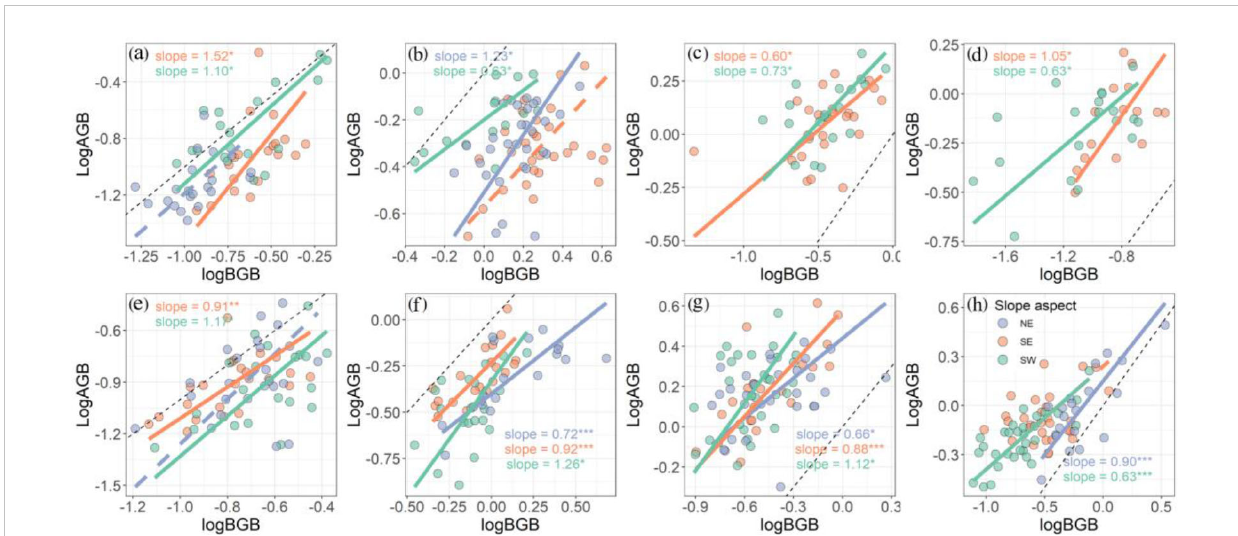
FIGURE 5 Effect of slope aspect on plant above- and belowground biomass allocation strategies at mountain A (A – D) and mountain B (E – H) . NE, SE, and SW refer to northeast, southeast, and southwest slope aspect, respectively. (A, E) Bistorta macrophylla ; (B, F) Bistorta vivipara ; (C, G) Cremanthodium discoideum ; (D, H) Deschampsia littoralis . Slope refers to the regression slope of each model with asterisks indicating signi fi cance (* p < 0.05, ** p < 0.01, and *** p < 0.001). Solid and dashed lines indicate the signi fi cant and non-signi fi cant relationships. The black dotted line is a line with slope equal to 1.